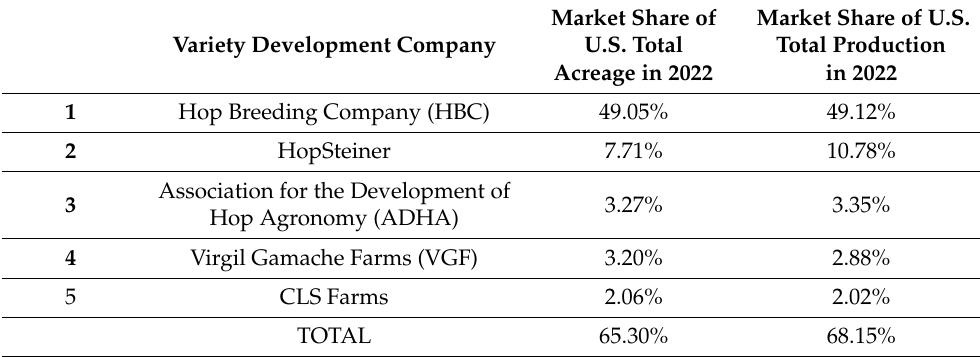
Table 1. Five largest U.S. hop variety development companies and the market share of U.S. acreage and production of their proprietary varieties in